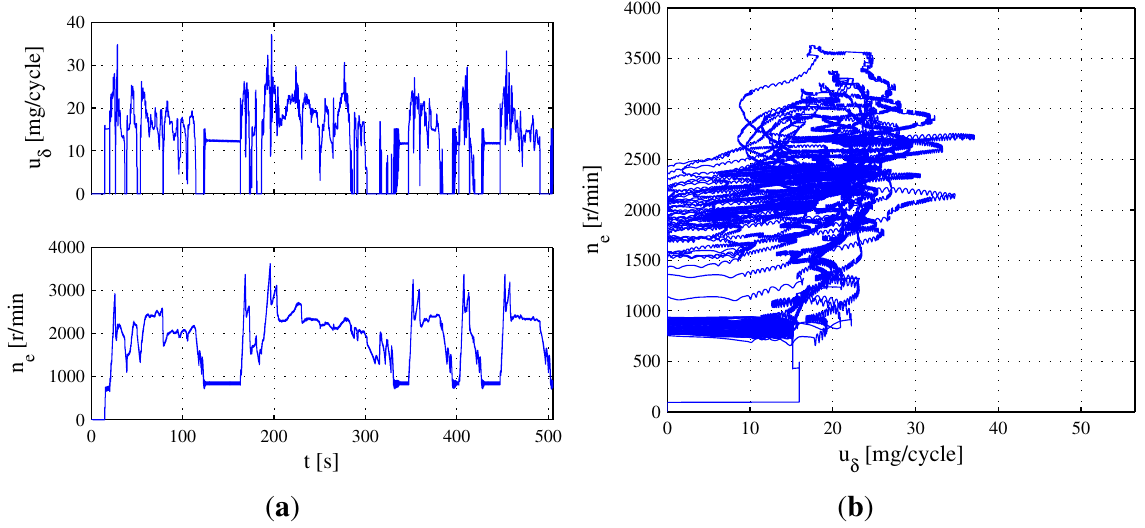
, n ) FTP75 cold start transient phase. δ e